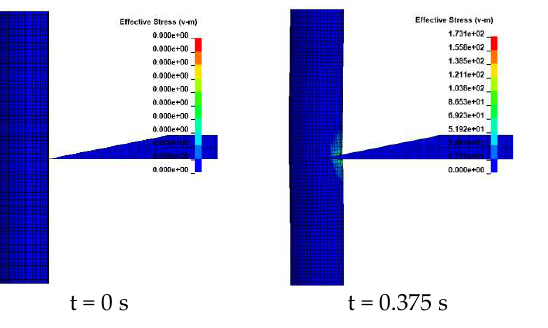
Figure 10. Stress diagram for citrus fruit stalk cutting simulation.